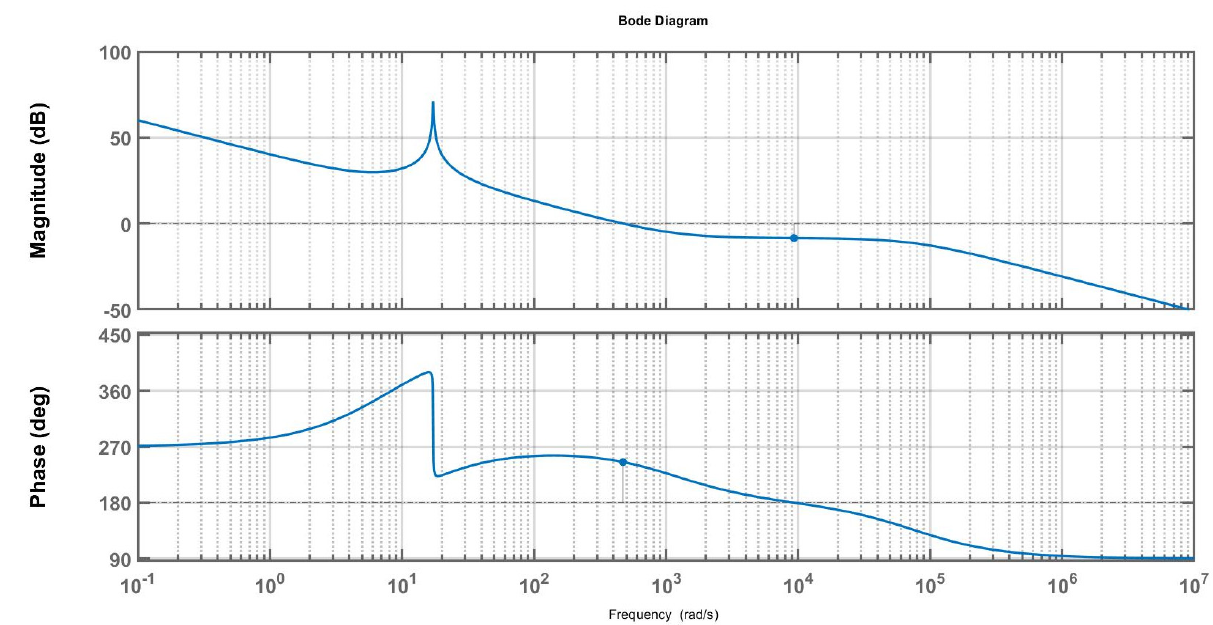
Figure 12. Bode plot of the closed loop DMRAC for the boost converter. The blue dot in Magnitude plot shows the gain margin (8.44 dB), and the blue dot in Phase plot shows the phase margin (65.3 deg).